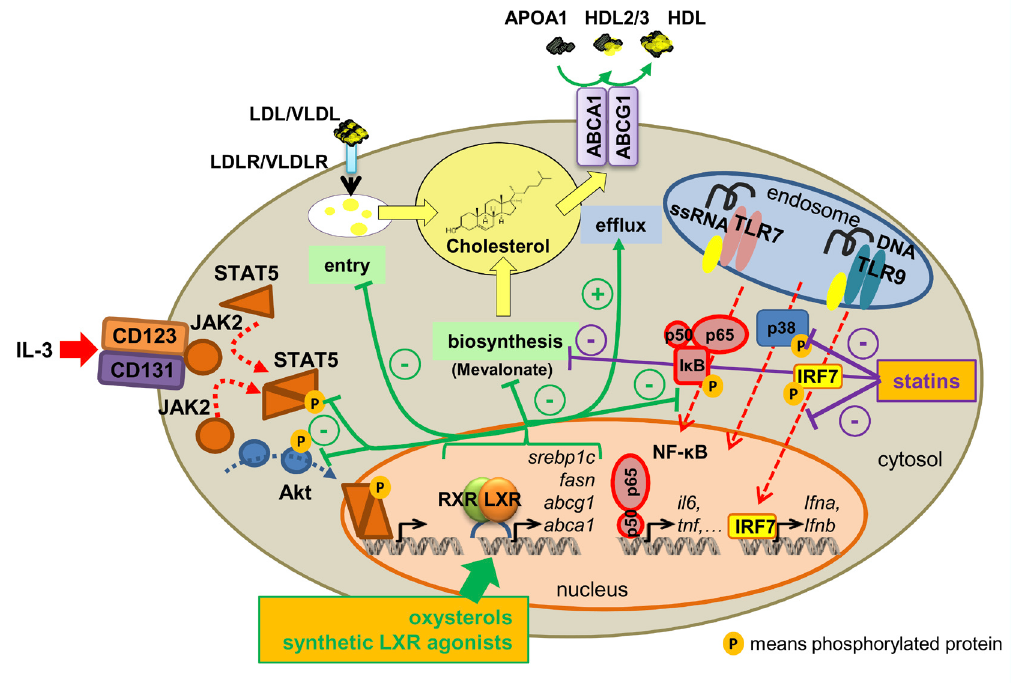
Figure 3. Cholesterol metabolism controls plasmacytoid dendritic cell (PDC) innate functions. Activation of the LXR pathway by “physiological” oxidized cholesterol derivatives (oxysterols) or synthetic LXR agonists induces the decrease of PDC intracellular cholesterol content by stimulating cholesterol efflux through ABCA1 cholesterol transporter, inhibiting cholesterol entry by decreasing LDL or VLDL receptor (LDLR and VLDLR, respectively) expression and inhibiting de novo cholesterol biosynthesis (also known as the mevalonate pathway). Cholesterol efflux via ABCA1 requires cholesterol acceptors, such as APOA1, and immature HDL (HDL2/3) to generate mature HDL that transport cholesterol towards the liver. Activation of this LXR pathway inhibits TLR7-induced NF- κ B activation and phosphorylation of STAT5 and Akt in response to IL-3 stimulation (green font and green arrows). Inhibition of cholesterol biosynthesis by statins (violet font and arrows) inhibits TLR7/9-induced IRF7 translocation in the nucleus, as well as phosphorylation of p38 kinase, and consequently the production of type I IFN. For more details and abbreviations, please refer to the main